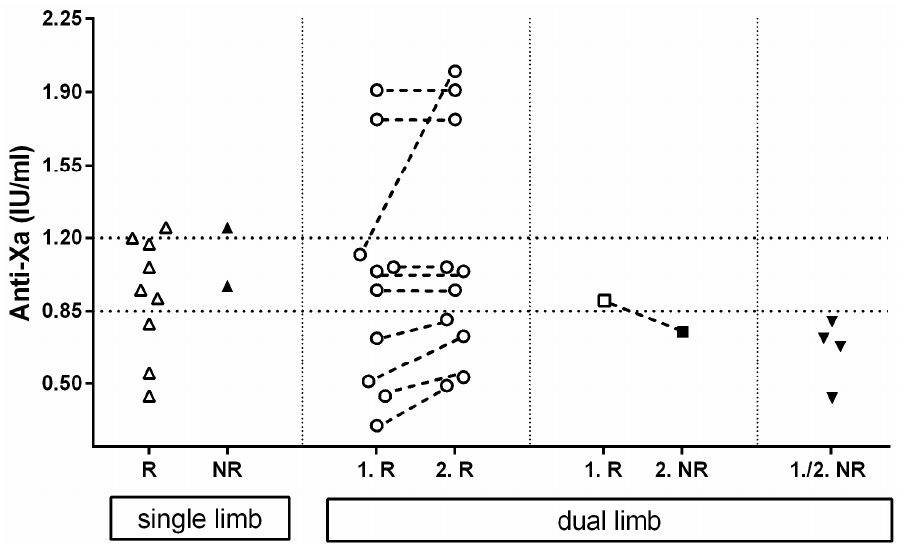
Figure 2. Schematical representation of anti-Xa activity of 26 cats (41 limbs) near reperfusion (R) or near death if no reperfusion (NR) occurred. Starting on the left, 11 cats with single limb ATE and reperfusion (R-open triangle) or no reperfusion (NR-closed upside triangle) and their anti-Xa values are depicted. Next are 10 cats with dual limb ATE with reperfusion (open circle) on first limb (1.R) and the second limb (2.R), and 1 cat with reperfusion on 1 limb (1.R-open square), but no reperfusion on the other limb (2.NR-closed square). Anti-Xa activities of conjugate legs are connected with a dashed line. Finally, on the right are 4 cats (8 limbs) with no reperfusion on either leg (1./2. NR-closed upside triangle).